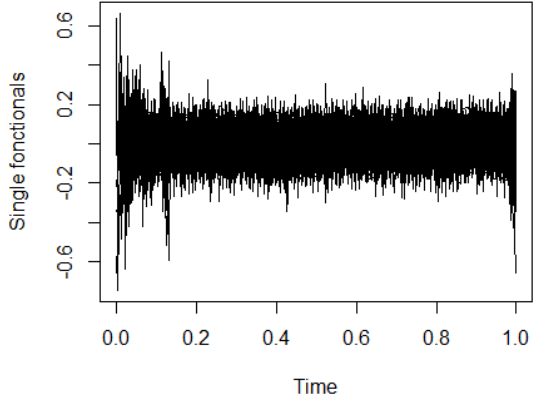
Figure 4: The curves θ i =1, ... ,215 (cid:0) t j (cid:1) , t j ∈ [0,